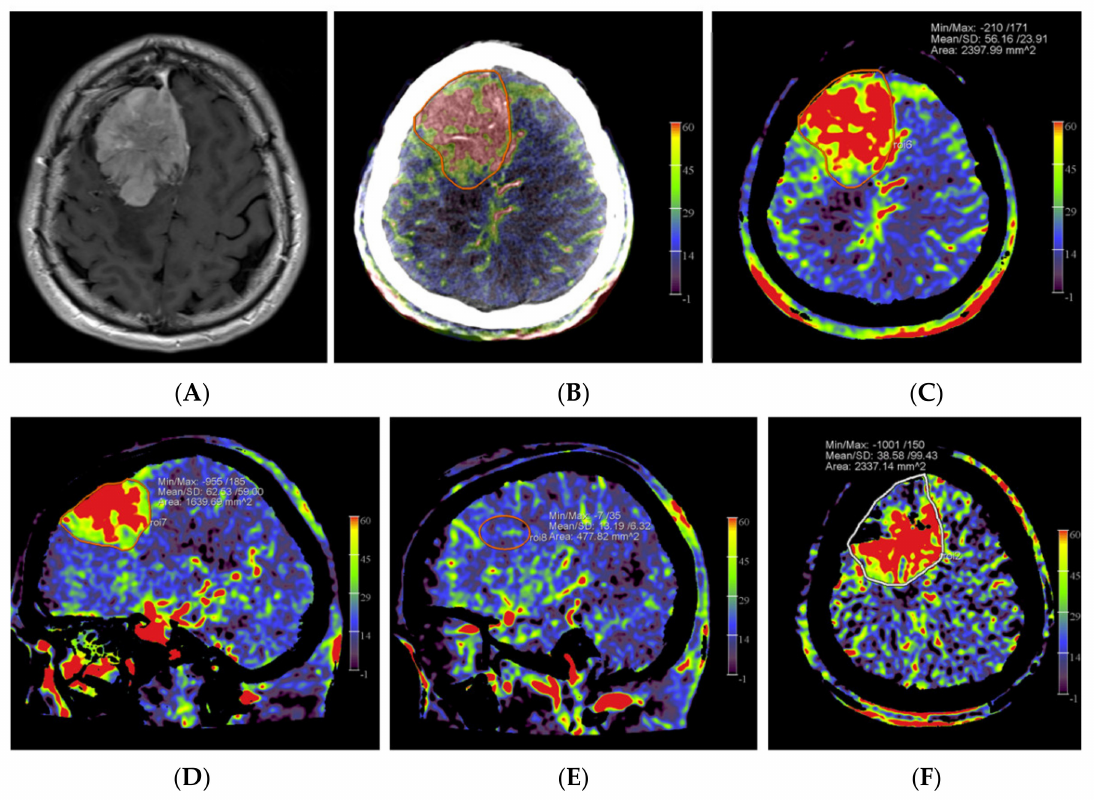
Figure 1. Example of PBV images pre- and post-embolization with manually drawn regions of interest (ROIs) in a patient with a right frontal convexity atypical meningioma (patient no. 2). Axial post-contrast T1-weighted MRI image ( A ) shows the tumor with vivid enhancement and